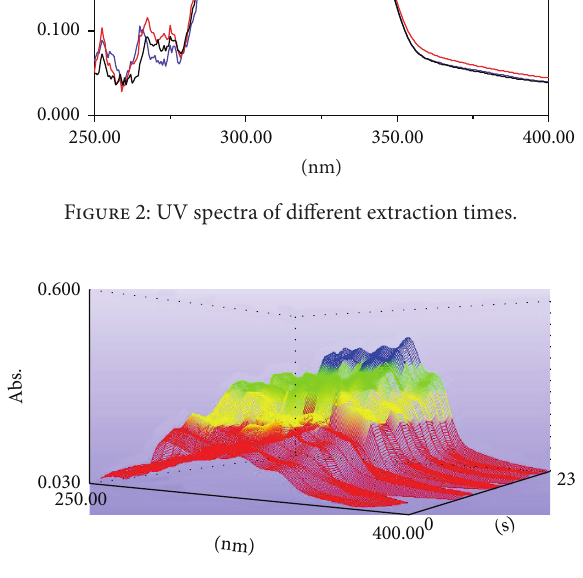
Figure 3: Three-dimensional wireframe plot of UV spectra of W. extensa sclerotium specimens.